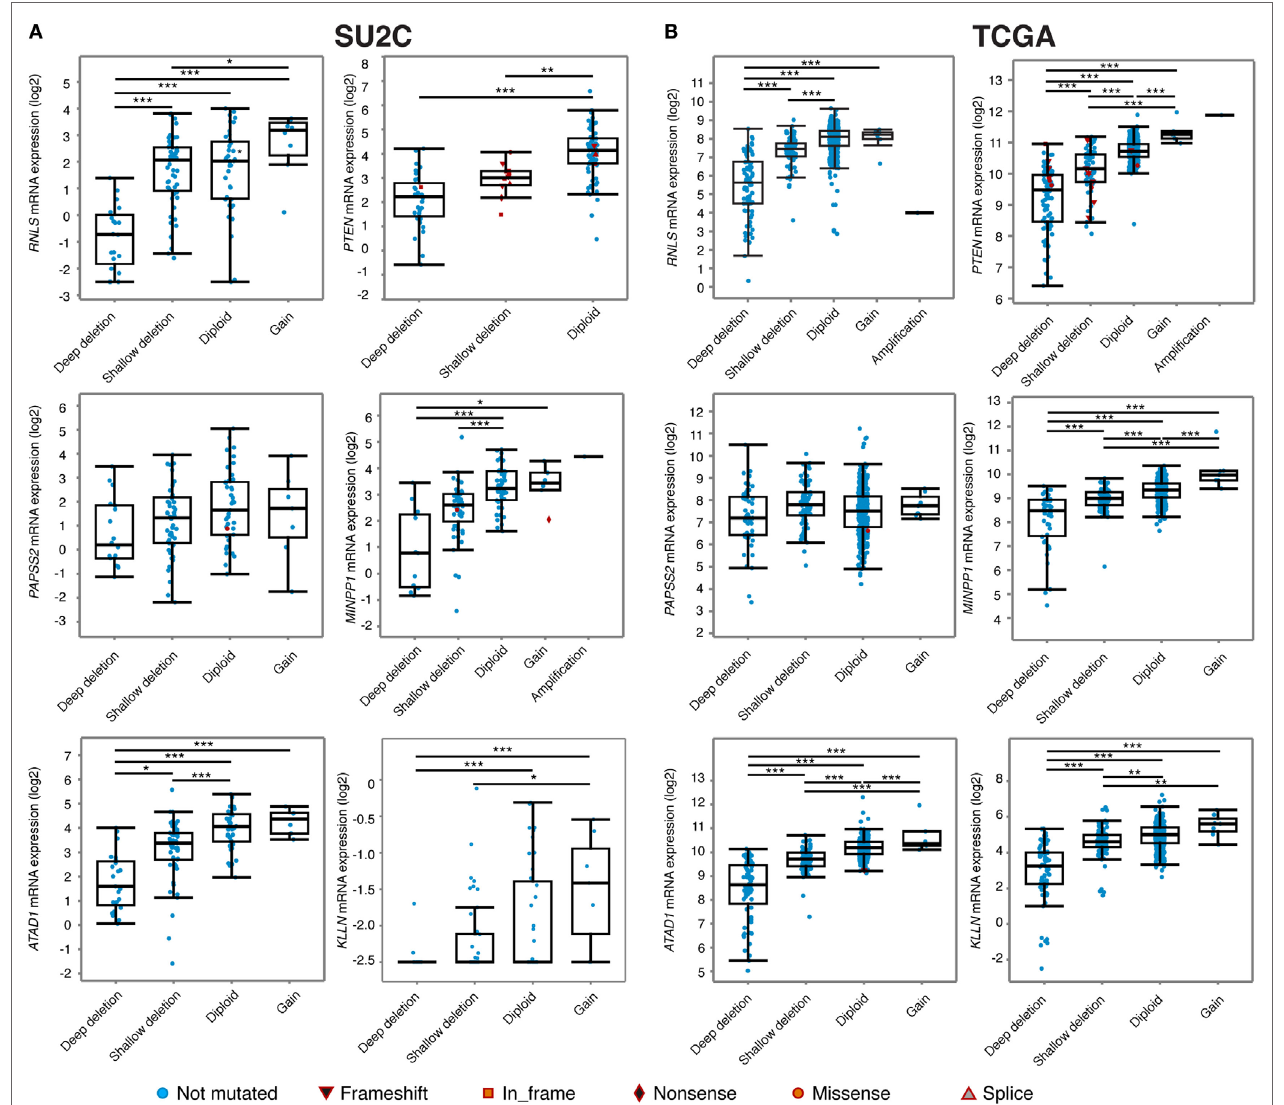
FiGUre 4 | Relationship between genomic alterations at the 10q23 locus and genes encompassed within this region. Expression of six genes located at the minimal deleted regions at the 10q23 locus in the Stand Up To Cancer (SU2C) (A) and the The Cancer Genome Atlas (TCGA) (B) prostate cancer cohorts. *** p < 0.001; ** p < 0.01; * p < 0.05 in ANOVA with post hoc Tukey’s Honest Significant Difference. Note that for RNLS and PTEN expression data in the TCGA cohort (B) , the sample with an amplification at 10q23 was not included for